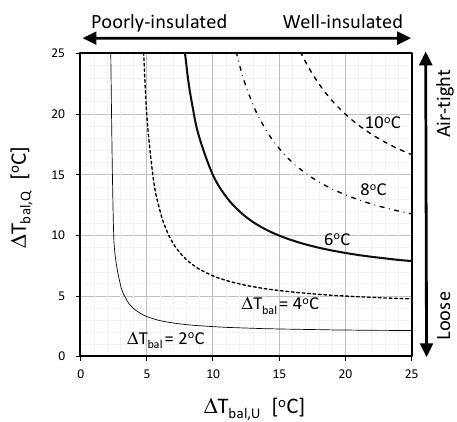
Figure 1. Balance temperature difference dependence on a building’s thermal characteristics.